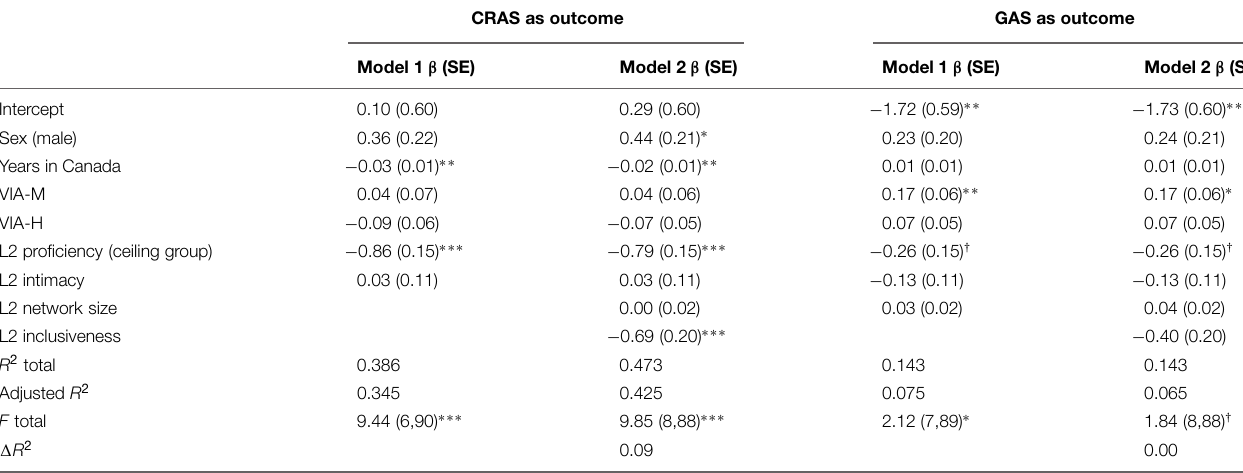
TABLE 2 | Multiple regression of Communication-Related Acculturative Stress (CRAS) and General Acculturative Stress (GAS) with inclusiveness as a measure of